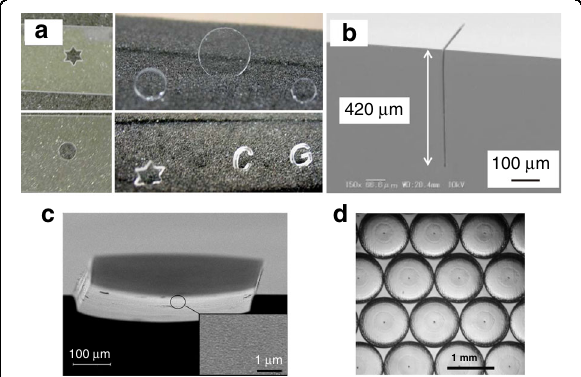
Fig. 10 Applications of LIBWE. a Different shapes were cut out from a 1-mm-thick glass substrate 73 . b High-aspect ratio (up to 60) trench fabricated on silica glass 83 . c SEM picture of a cylindrical structure etched into fused silica employing contour mask technique in conjunction with backside etching. The micro-roughness of the surface is below 10 nm RMS at a tech depth of more than 50 μ m 77